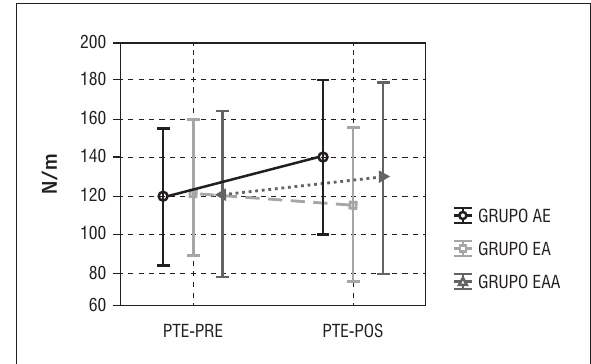
Figura 3 - Média e desvio-padrão do PTE, dado em Newton por metro (N/m), antes e depois da aplicação de alonga- mento estático (AE), do exercício aeróbico (EA) e do alongamento estático mais exercício aeróbico (EAA)